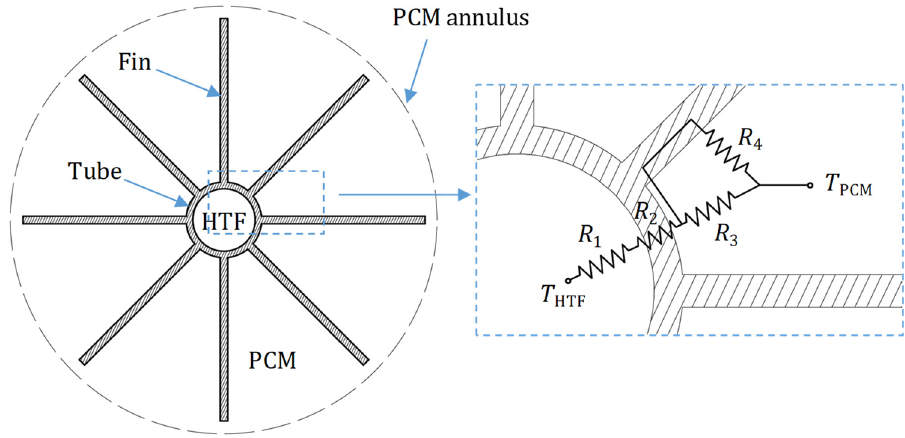
Figure 4. Schematic representation of a PCM annulus and the detail showing schematic representation of thermal resistances between HTF and PCM.